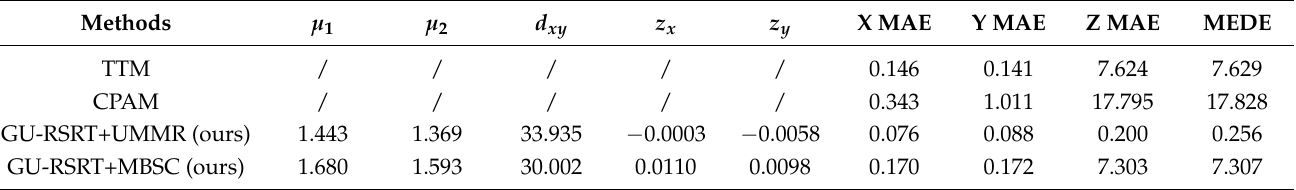
Table 5. The calibration results and 3D reconstruction errors of GelStereo Palm2.0 sensor. The unit of d xy , X MAE, Y MAE, Z MAE, and MEDE is mm.